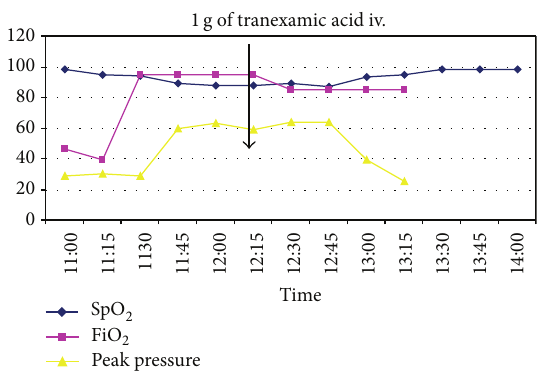
Figure 1: Clinical course: oxygen saturation, FiO 2 and peak inspi- ratory